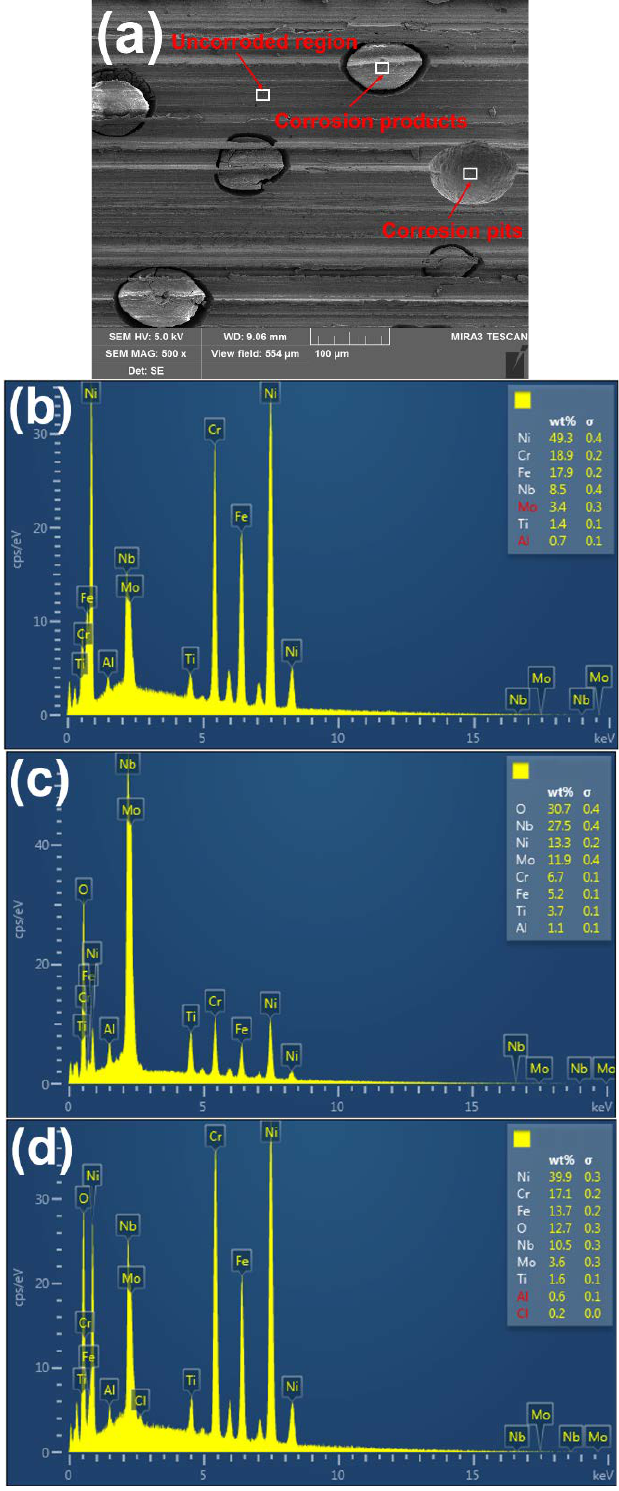
Figure 7. SEM and energy dispersive X-ray spectroscopy (EDS) results for the corroded specimens: ( a ) SEM image; ( b ) Uncorroded surface; ( c ) Corrosion products; ( d ) Corrosion pits.